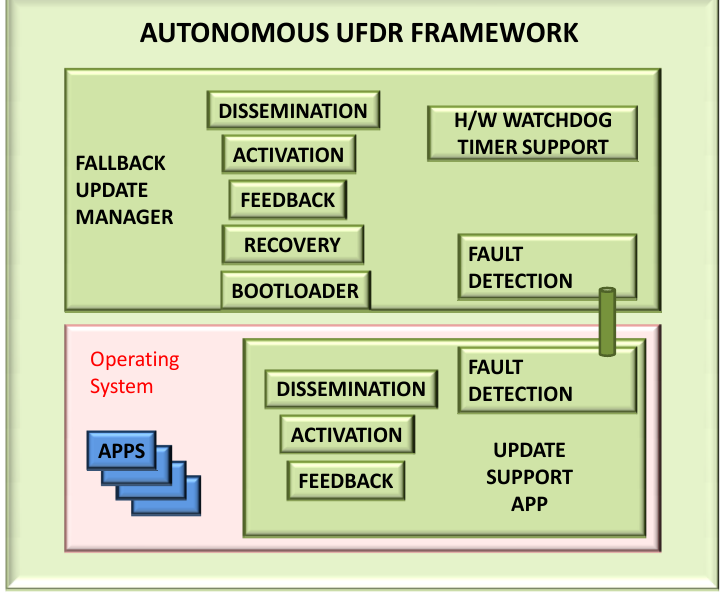
Figure 6. A Model for Software Update Fault Detection and